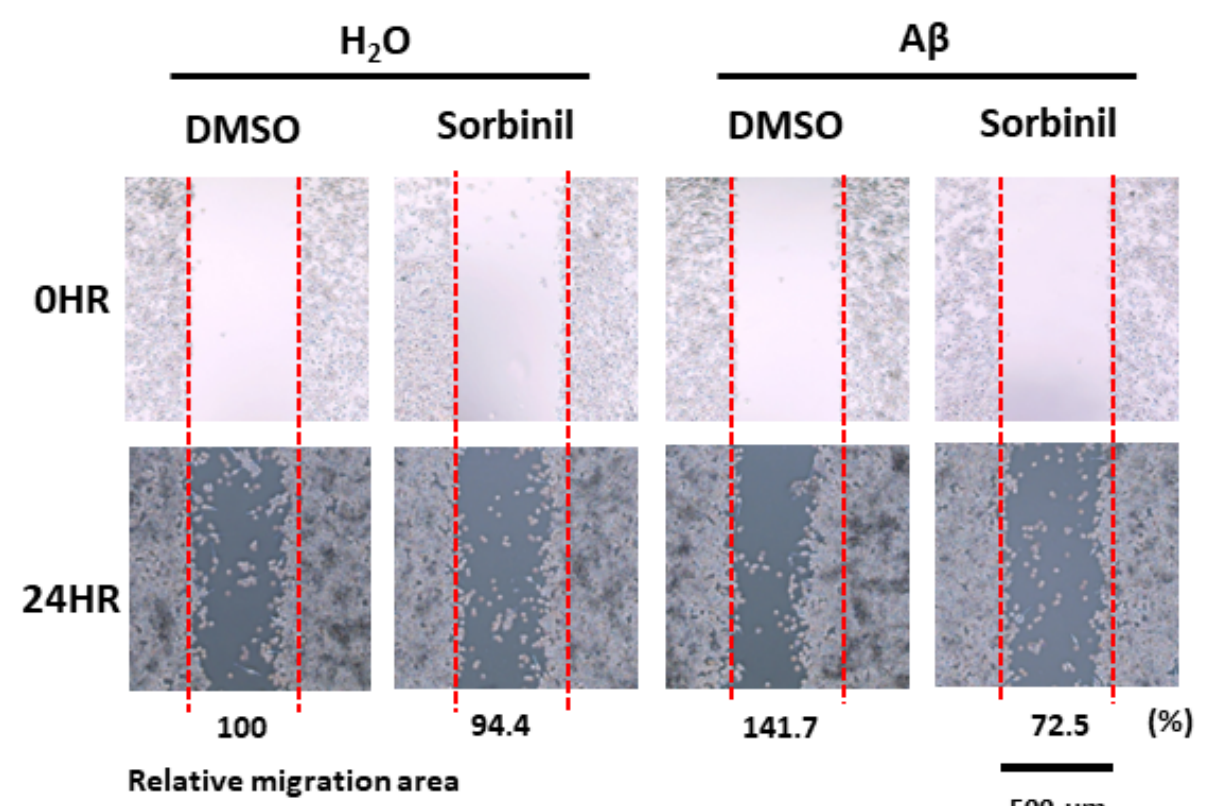
Figure 3. AR inhibition decelerates cell migration in BV 2 cells. Representative images of migration of BV 2 cells after treatment with β -amyloid (A β ; 10 µ M) or H 2 O control and treatment with sorbinil (10 µ M) or DMSO control. Numbers at the bottom of images show relative migration area of BV 2 cells in each group compared to untreated controls.